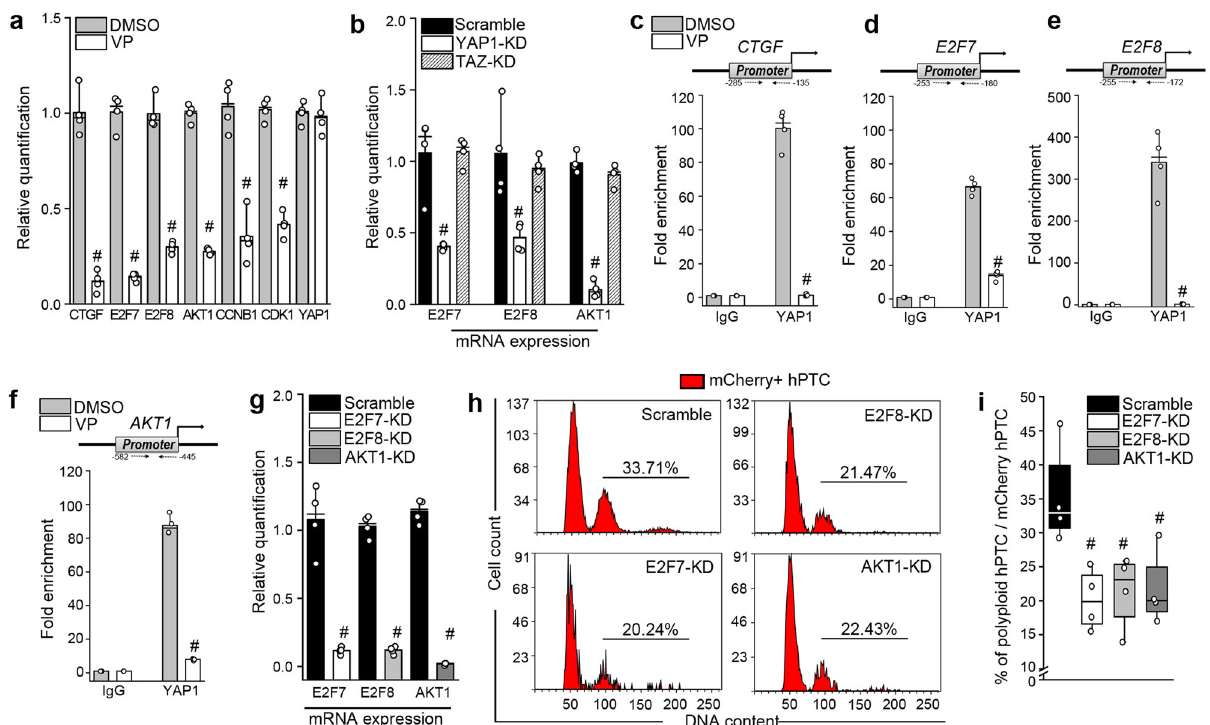
Fig. 4 | YAP1 controls polyploidization via AKT1, E2F7 and E2F8 activation. a qRT-PCRanalysisofYAP1targetsinDMSOandvertepor fi n(VP)treatedmCherry- hPTC ( n =4). CTGF was used as a positive control. YAP1 was used as a negative control.#Signi fi cancebetweenDMSOandVPtreatedmCherry-hPTCforeachgene analysed, p =0.028. b qRT-PCR quanti fi cation of E2F7, E2F8and AKT1inscramble, YAP1, and TAZ knock-down (KD) mCherry-hPTC ( n =4). # Signi fi cance between scrambleandYAP1-KDmCherry-hPTCforeachgeneanalysed, p =0.028.Scramble and TAZ-KD conditions are not signi fi cantly different. Chromatin immunopreci- pitation assay showing YAP1 binding on c CTGF, d E2F7, e E2F8 and f AKT1 pro- moters in DMSO and VP treated mCherry-hPTC ( n =4). #Signi fi cance